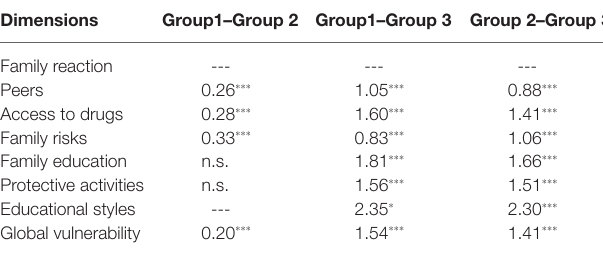
TABLE 6 | Cohen’s d indexes for post hoc contrast groups.